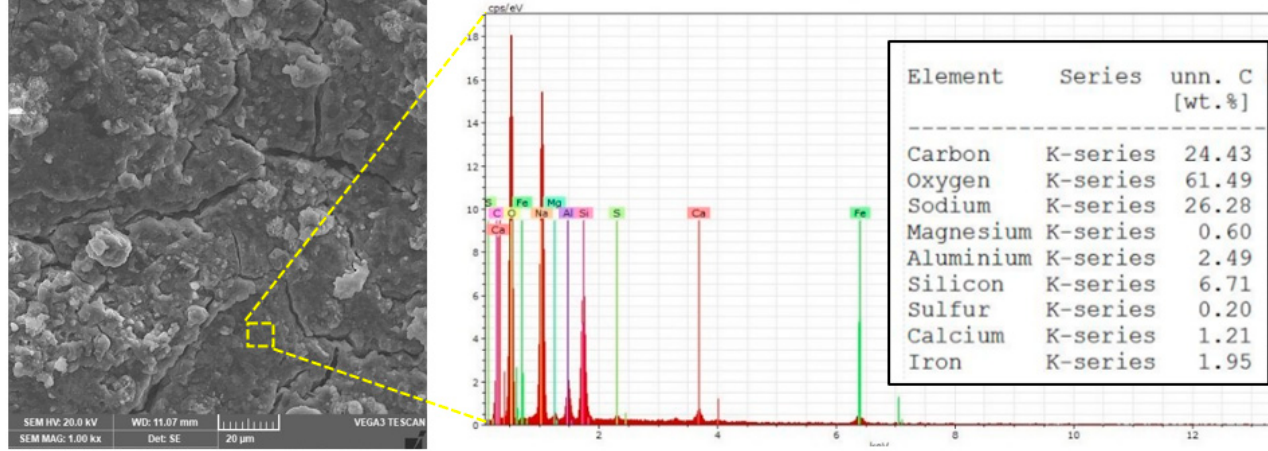
Figure 10. SEM/EDX of geopolymer paste.